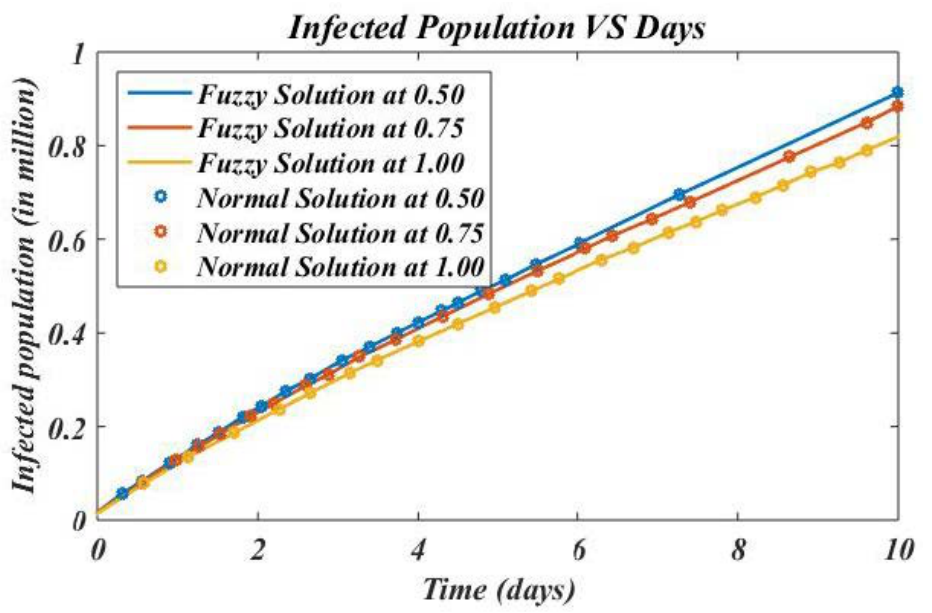
Figure 3. Illustration of approximate fuzzy and normal infected compartment solutions for three terms at given uncertainty levels ϑ ∈ [ 1,2 ] versus fractional order